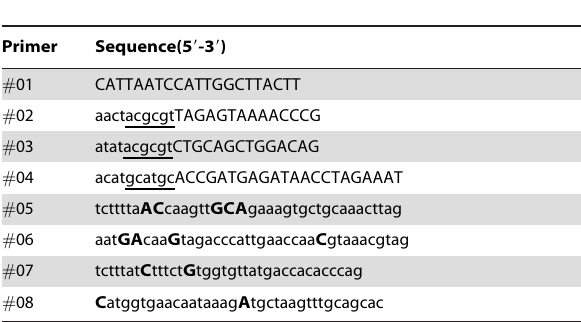
Bold: modified nucleotides. Underlined: modified or newly generated endonuclease restriction